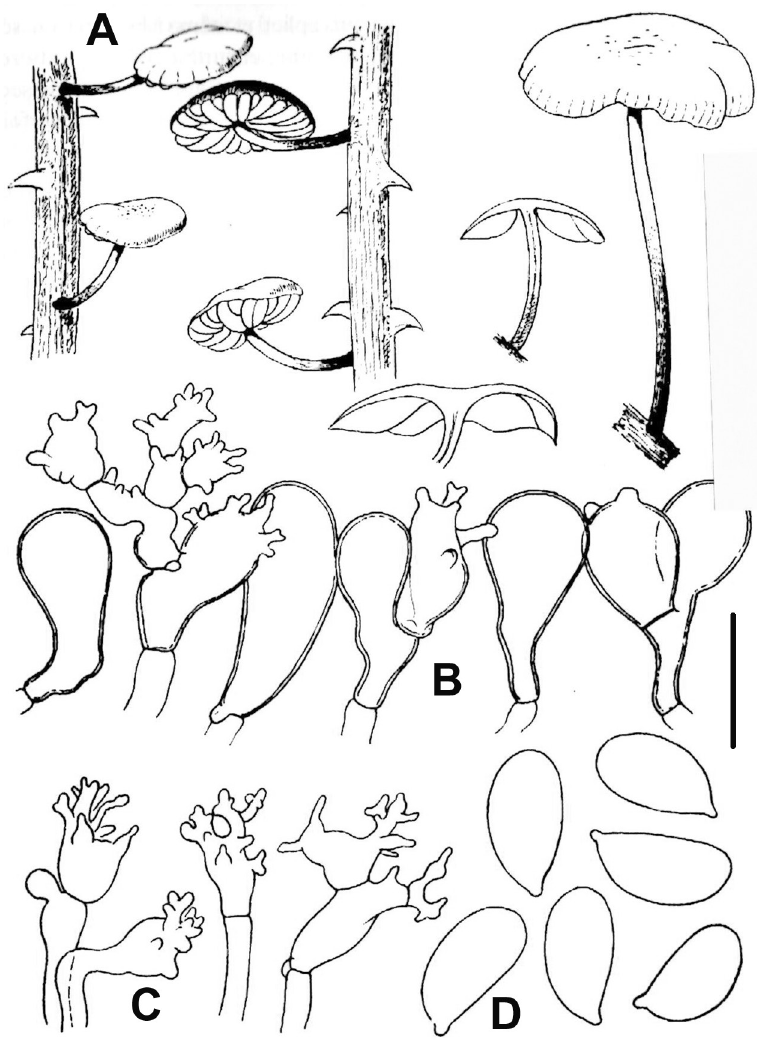
Figure 85. Mycetinis virgultorum . A Basidiomata B Pileipellis structures C Cheilocystidia D Basidi- ospores. Standard bars: B–D = 10 µm; A = not to scale; smaller basidiomata circ. 2×, basidiome at right circ. 5×. Adopted from Malençon & Bertault, 1975. little pruinose at apex, downward smooth or hairy (entirely furfuraceous-squamulose, strigose at base, teste Antonin 1995) (“avec seulement quelque courts trichoïdes bruns àla base” teste Eyssartier and Moreau 2001), cream colored at apex, amber and darker to brown-red downward (“rouge-purpurin sombre” teste Eyssartier and Moreau 2001). Flesh thin, white or weakly tinted under the union to stipe or apex of stipe, rosy at its base. Odor of garlic, perceived in nature even before the basidiomata; taste similar (teste Antonín